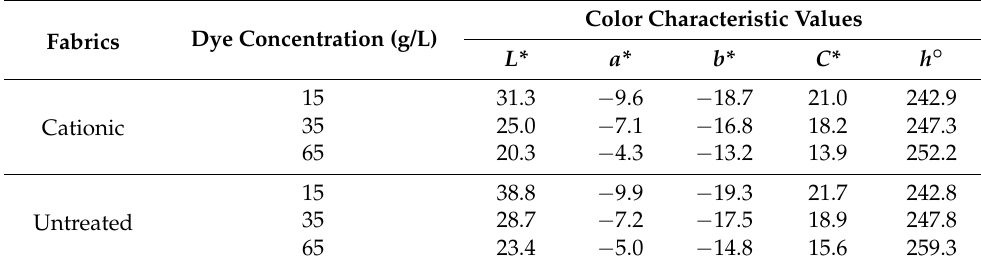
Table 1. Color characteristic values of dyed fabrics a .